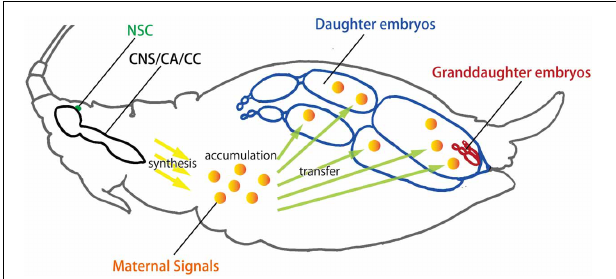
FIGURE 4 | Transgenerational transfer of maternal signals in viviparous aphids. Viviparity in aphids is classified as pseudoplacental viviparity. Interestingly, the granddaughters of a female aphid (viviparous mother) are already developing within the daughters inside the mother. This telescoping association creates a unique opportunity for the mother to convey environmental information directly to her daughters (and granddaughters in some situations) via her hemolymph through the ovariole sheath. The multi-step events leading to the production of different aphid polyphenisms are hypothesized in this reproductive unit: (1) the mother perceives environmental information and integrates the information, probably via the NSC or CNS; (2) the mother converts the stimuli into a transmissible signal, probably in the CA or CC; (3) this signal is transmitted to the daughter embryos developing in the ovarioles of the mother; (4) the daughter embryos respond to the signal. CA, corpora allata; CC, corpora cardiaca; CNS, central nerve system; NSC, neuro secretory